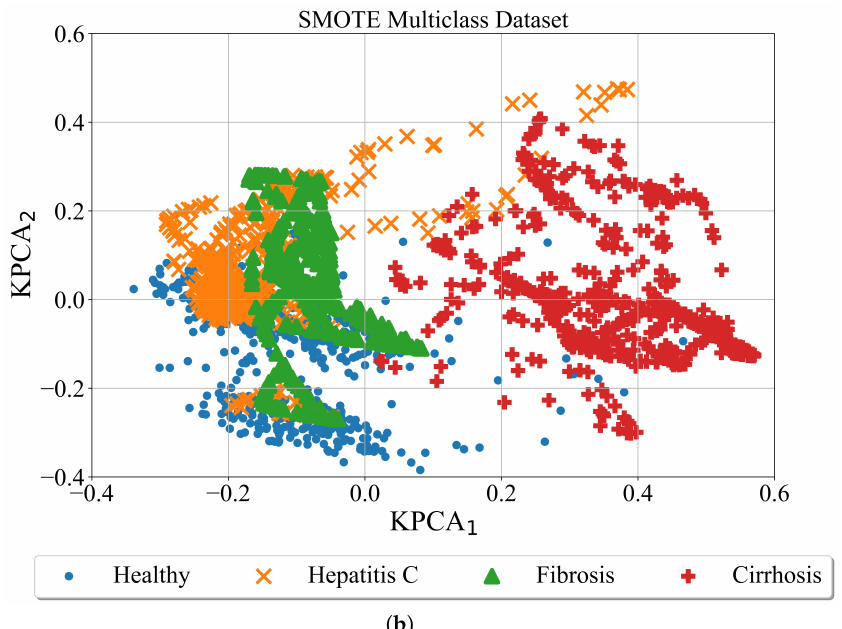
Figure 6. The results of SMOTE oversampling technique application on binary and multiclass dataset. ( a ) SMOTE oversampled Binary Dataset; ( b ) SMOTE Oversampled Multiclass